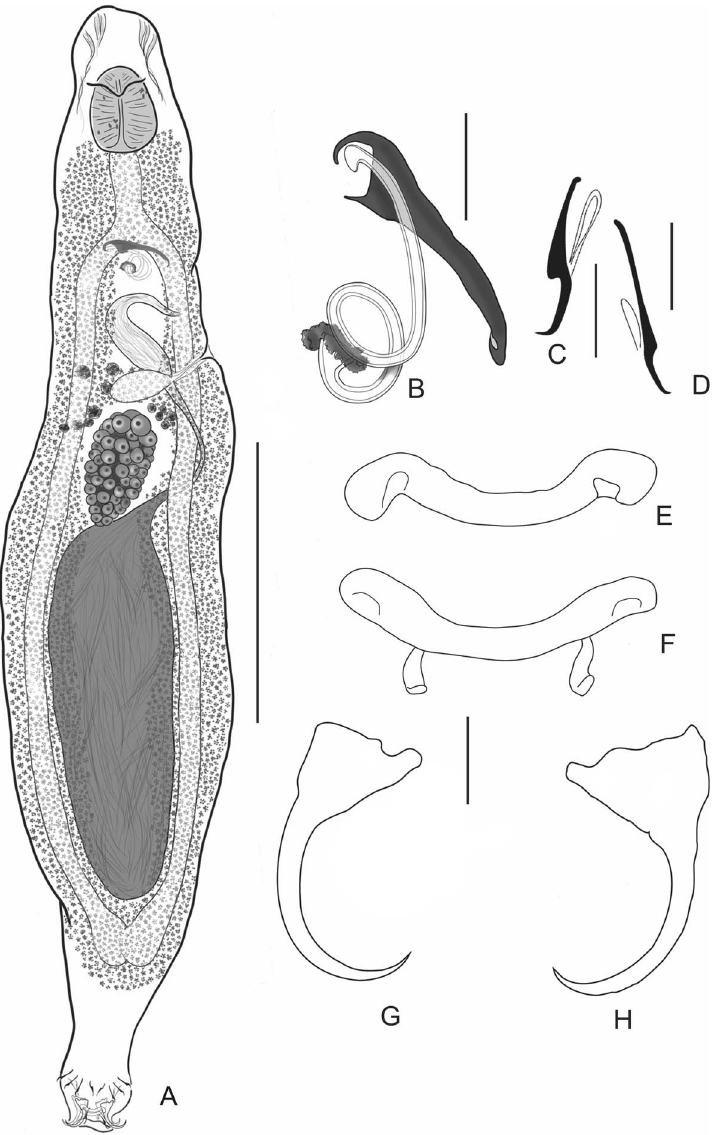
Figure 2. Cosmetocleithrum nunani n. sp. from Auchenipterus nuchalis . (A) Holotype, in ventral view (composite); (B) Copulatory complex, ventral view; (C) Hook pair 1; (D) Hook pair 5; (E) Ventral bar; (F) Dorsal bar; (G) Ventral anchor; (H) Dorsal anchor. Scale bars: (A) 300 l